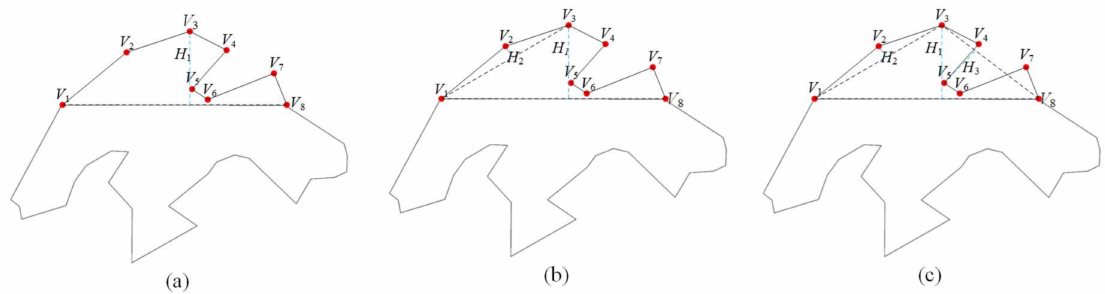
Figure 2. Using the Douglas Peucker (DP) algorithm to weight vertexes [18]. ( a ) V 3 is weighted according to H 1 , ( b ) V 2 is weighted according to H 2 , ( c ) V 4 is weighted according to H 3